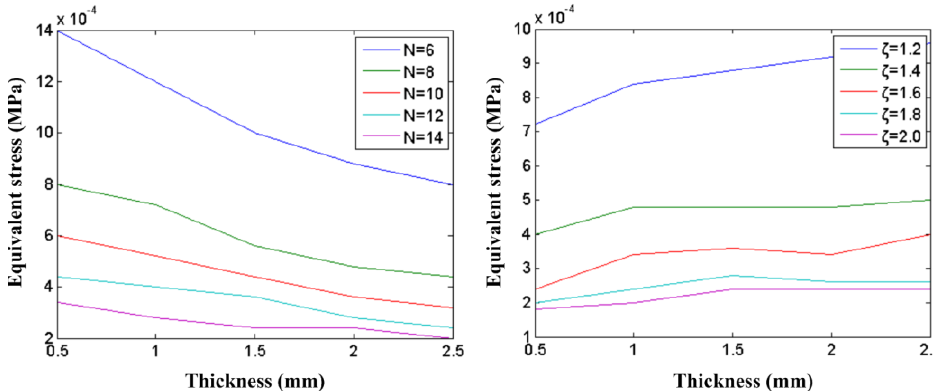
Figure 12. Influence of design parameters on the structural stress of the flange.